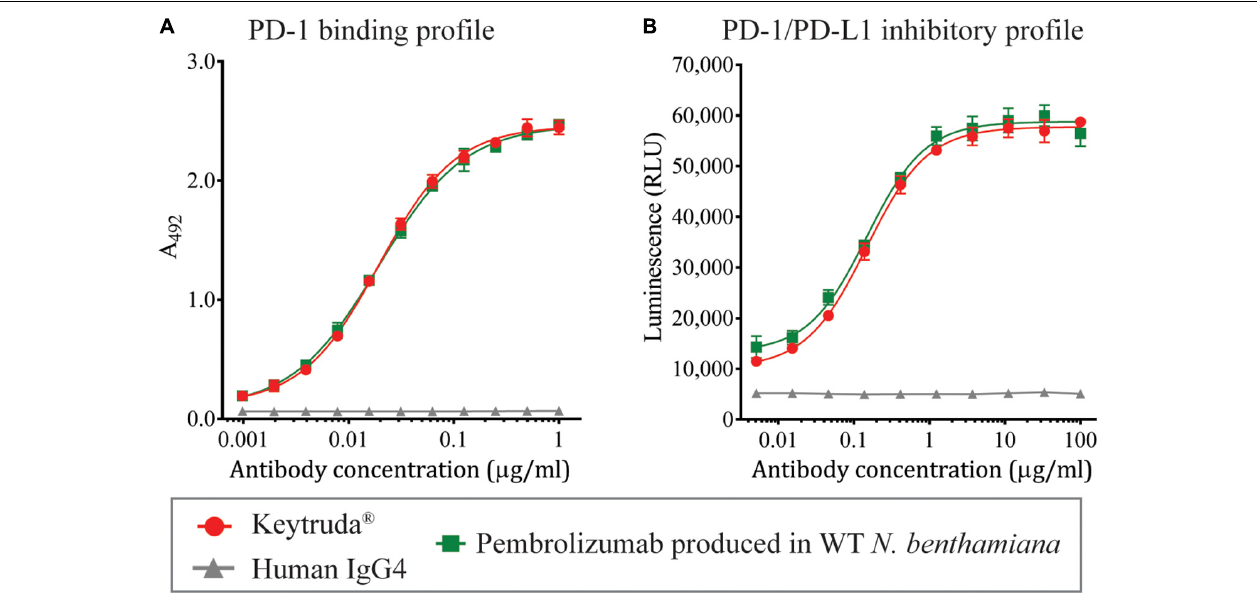
FIGURE 4 | Binding and inhibition profiles of plant-produced Pembrolizumab. Purified plant-produced Pembrolizumab was assessed for the (A) binding activity with human PD-1 by ELISA and (B) PD-1/PD-L1 inhibition activity by PD-1/PD-L1 blockade bioassay. The Keytruda R (cid:13) and human IgG4 were used as positive and negative control, respectively. Data are presented as mean ±